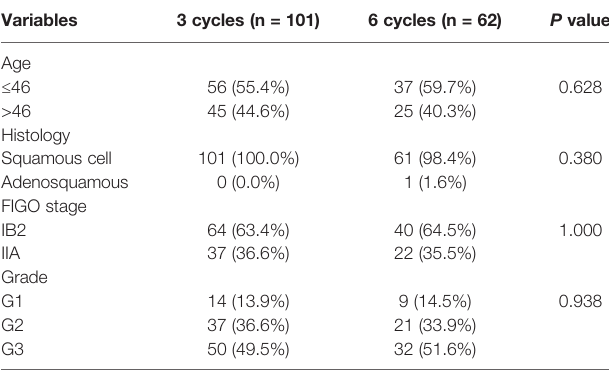
FIGO, International Federation of Gynecology and